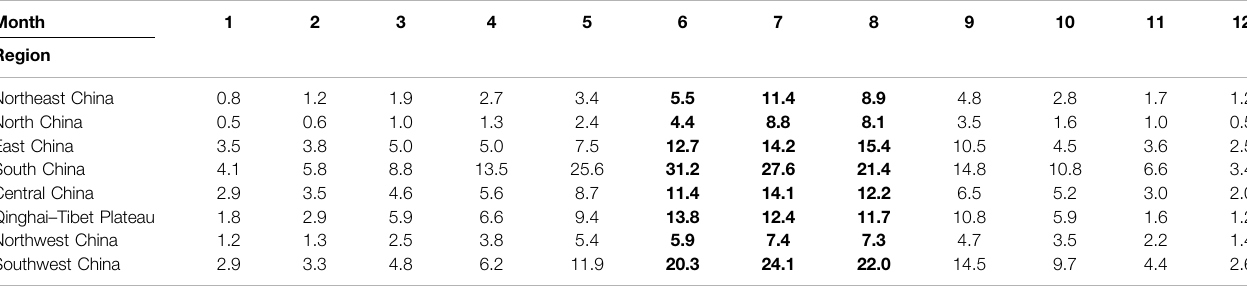
TABLE 1 | MAE of cross-validation for the climatology value (unit: mm). Month 1 2 Region Northeast China 0.8